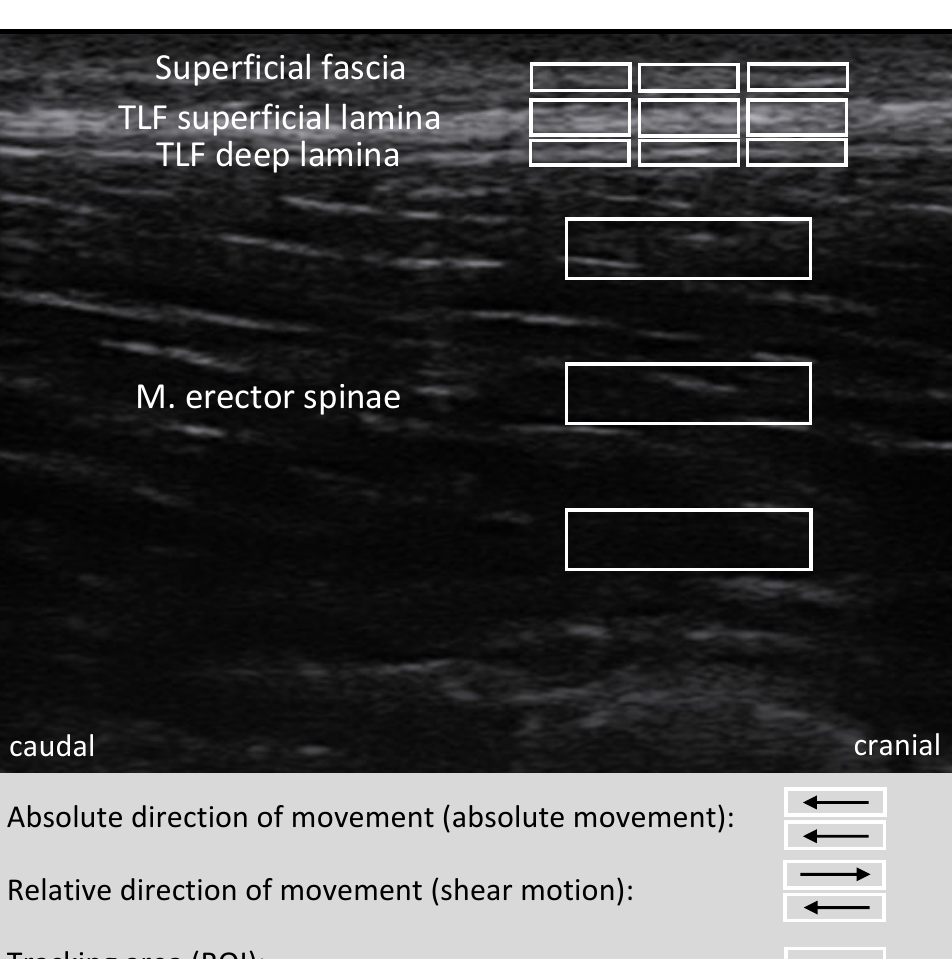
Figure 3. Schematic replica of Dilley’s (2001) shear motion analysis. TLF: thoracolumbar fascia; M.: muscle; ROI: region of interest. Adapted from the original by Weber et al. (2018) [53].